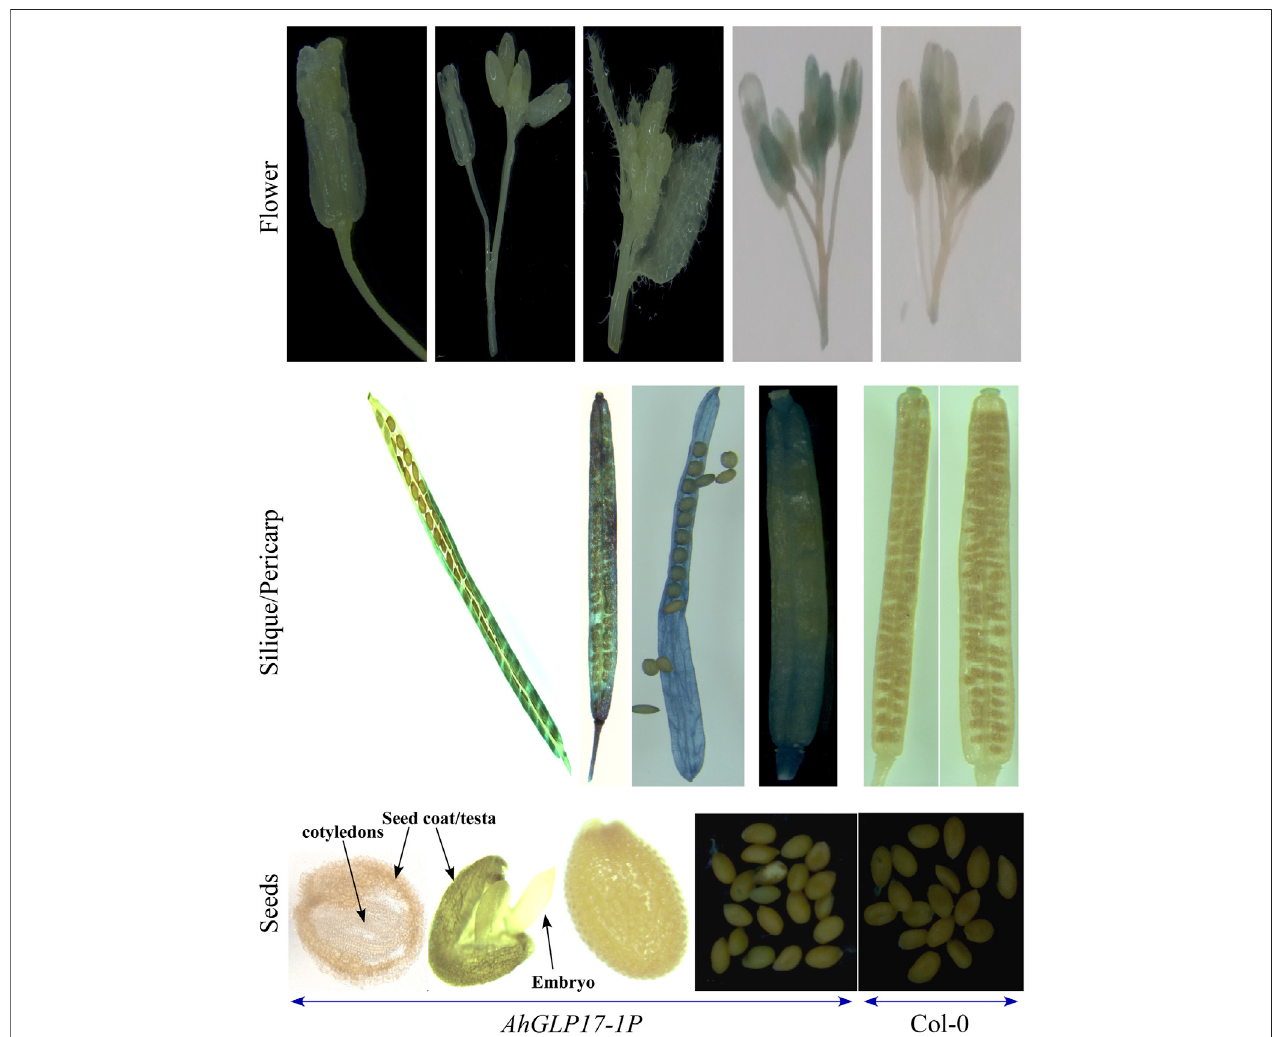
FIGURE 7 | GUS staining of different reproductive tissues/organs of transgenic Arabidopsis plants. AhGLP17-1P plants showed no staining in fl owers (a minute staining in some cases). Seed outer covering (pericarp) showed good staining. While staining was not present in any seed tissue (testa, cotyledons, and embryo).